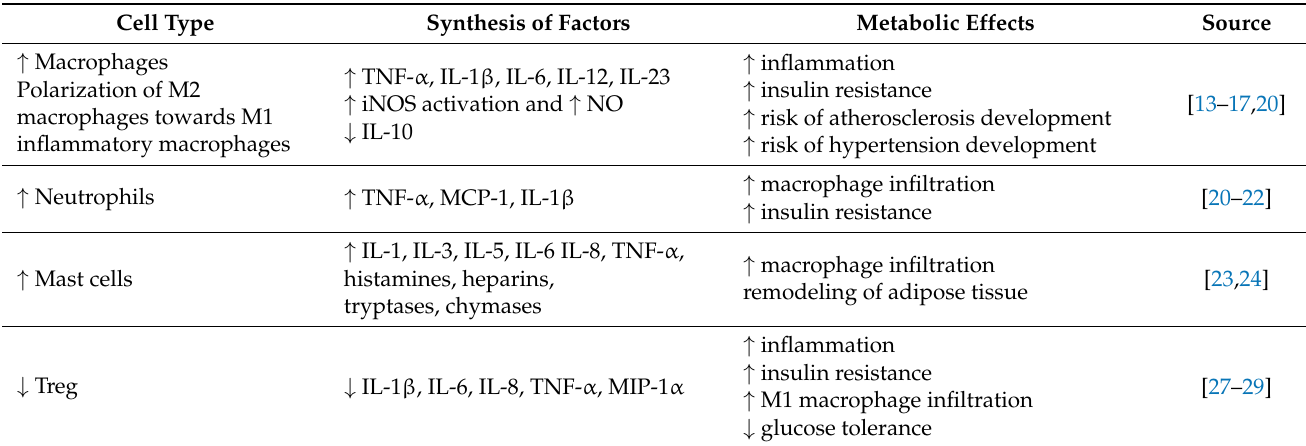
Table 1. Adipose tissue in obesity—selected metabolic